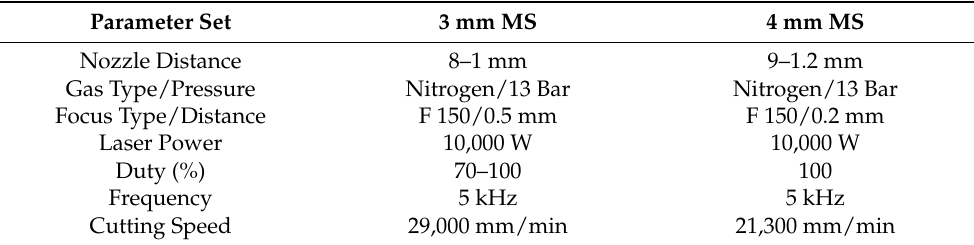
Table 6. Example piercing and cutting parameter set used in 10 kW tests.